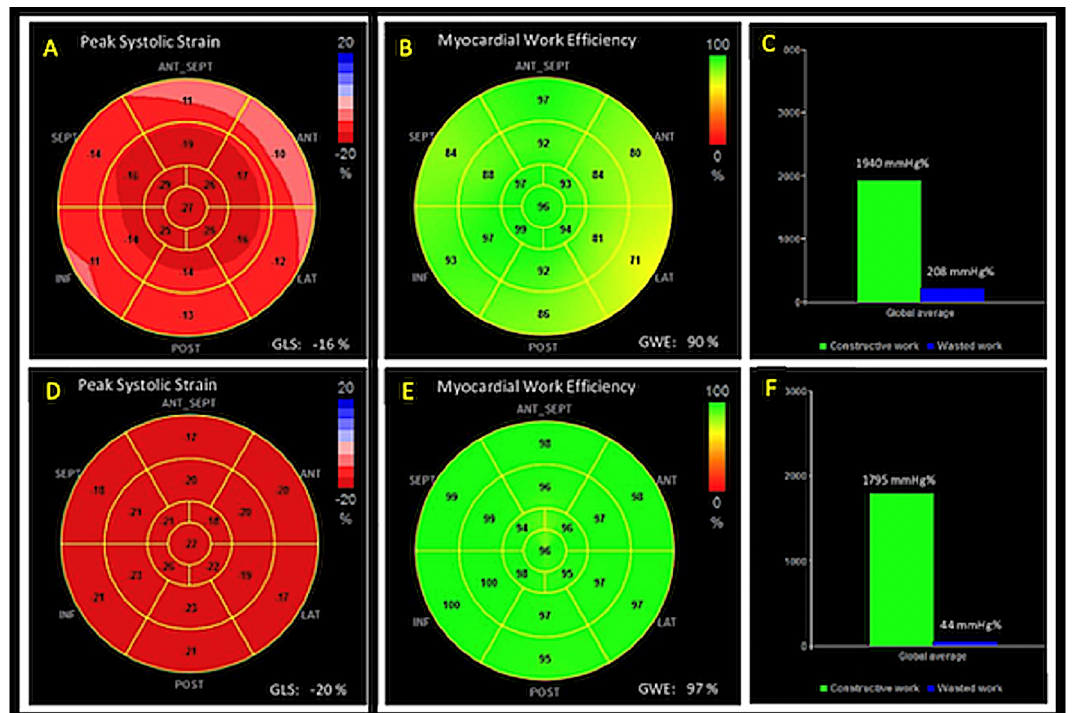
Figure 2. Panels ( A – C ): 17-segment bull’s-eye representation of LV strain ( A ), and myocardial work efficiency ( B ) and wasted work ( C ) in a patient after ACS performing rehabilitation. Both myocardial deformation (GLS − 16%) and efficiency (90%) were moderately impaired. Panels ( D – F ): 17-segment bull’s-eye representation of LV strain ( D ), and myocardial work efficiency ( E ) and wasted work ( F ) in a healthy control. Both myocardial deformation (GLS − 20%) and efficiency (97%) were within normal limits.